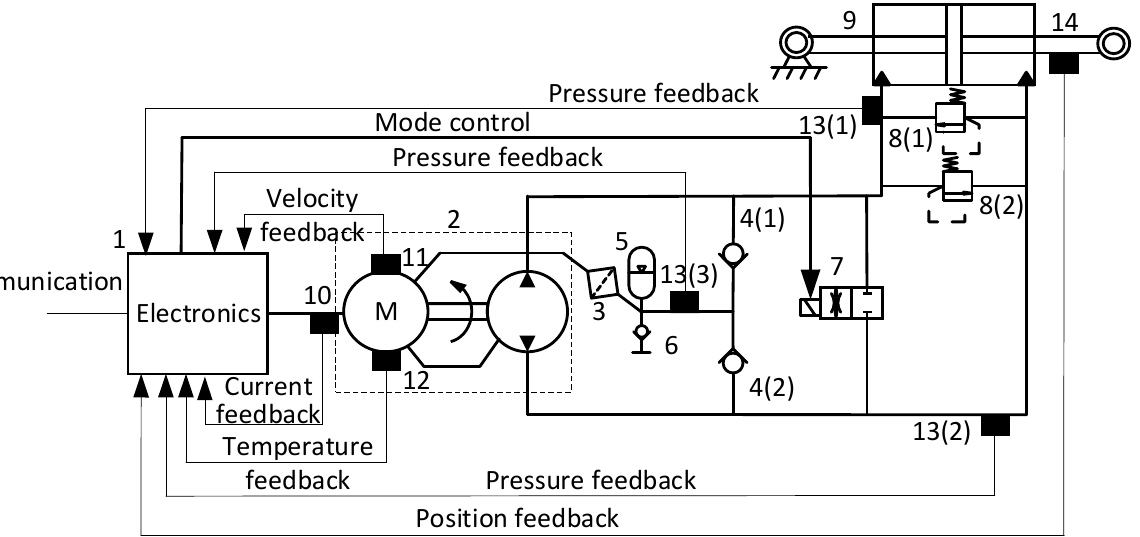
Figure 2. The EHA schematics from the conceptual design [27]. (1) electronics; (2) electric motor-pump unit; (3) filter; (4) check valves; (5) reservoir; (6) filling port; (7) mode control valve; (8) relief valves; (9) cylinder; (10) current sensor; (11) rotational speed sensor; (12) temperature sensor; (13) pressure sensors; (14) displacement sensor. Table 1. The system-level performance requirements of a 30 kW EHA [27]. Symbol Description Value Unit